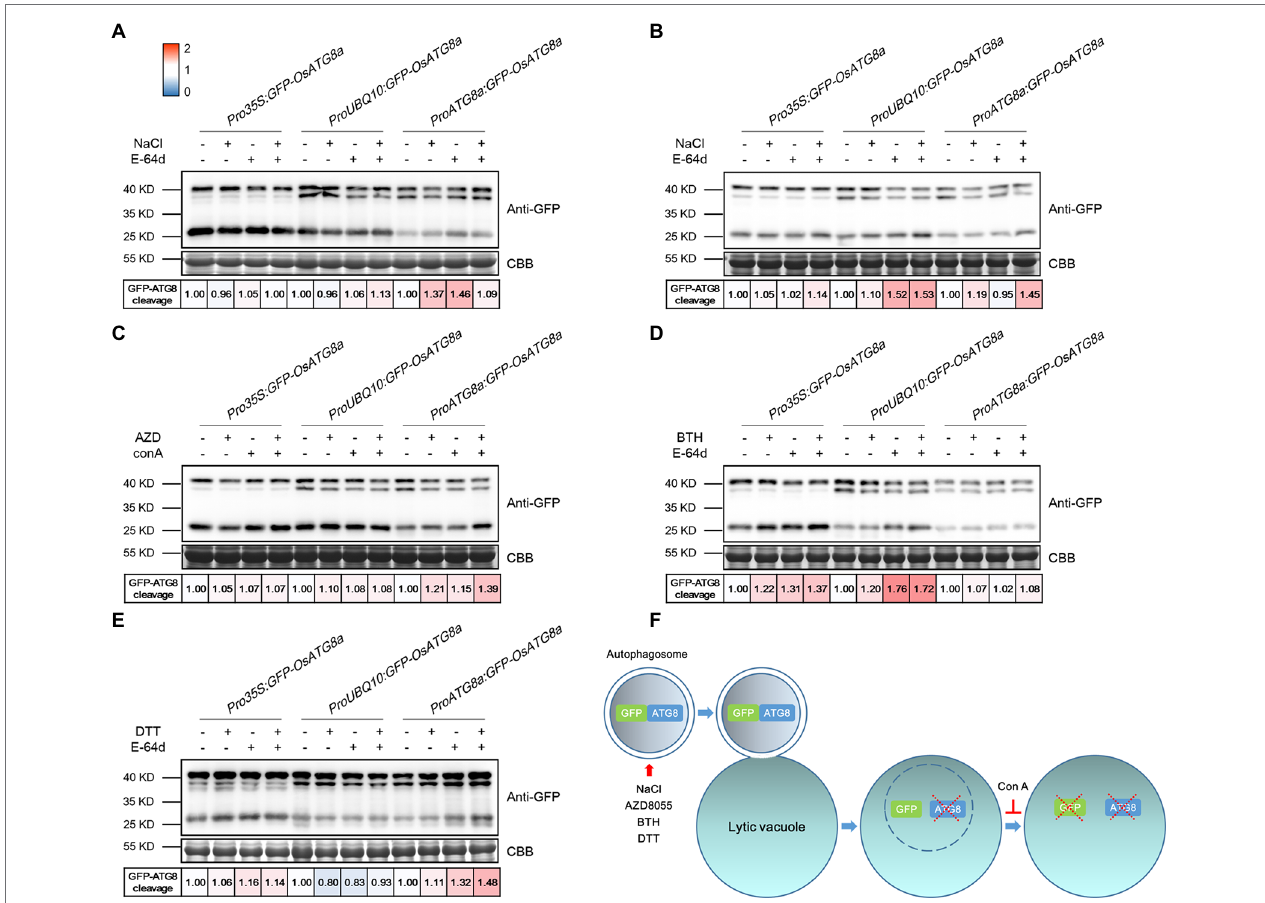
FIGURE 3 | Measuring autophagic flux in GFP-OsATG8a marker lines. The level of autophagic flux is represented by the difference of the GFP-ATG8 cleavage between control and treatment. GFP-ATG8 cleavage was calculated as the ratio of the free GFP band (27 kD) to the total GFP signal in the lane (40kD plus 27 kD), then normalized to the respective control (no treatment, no E-64d or ConA; set as 1.00). A color scale (Blue for 0, white for 1, and red for 2) was used to illustrate the semi-quantified values of GFP-ATG8 cleavage. Coomassie Brilliant Blue (CBB) staining of RuBisCO large subunit was used as loading control. (A) For moderate salt stress-induced autophagy, excised leaves from 14-day-old rice seedlings were incubated in the Hoagland’s solution plus 150 mM NaCl, or 100 μ M E-64d, or both NaCl and E-64d for 1 h. (B) For severe salt stress-induced autophagy, leaves were incubated in 250 mM NaCl and 100 μ M E-64d for 1 h. (C) For TOR inhibition-induced autophagy, leaves were incubated in 2 μ M AZD8055 and 1 μ M Concanamycin A for 6 h. (D) For BTH-induced autophagy, 200 μ M BTH and 100 μ M E-64d for 6 h were used. (E) For ER stress-induced autophagy, 2 mM DTT and 100 μ M E-64d for 4 h were used. At least three biological replicates were done for each treatment, and one representative replicate is shown. (F) A diagram illustrating the GFP cleavage assay and the chemicals